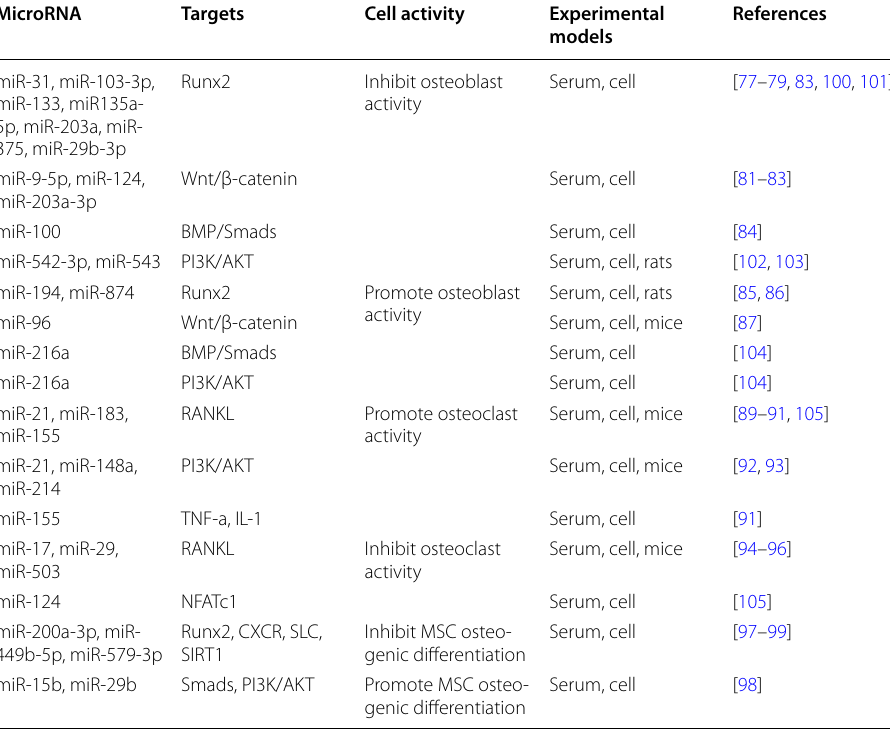
Table 1 The effects of microRNAs (miRNAs) on the activity of bone cells MicroRNA Targets Cell activity Experimental